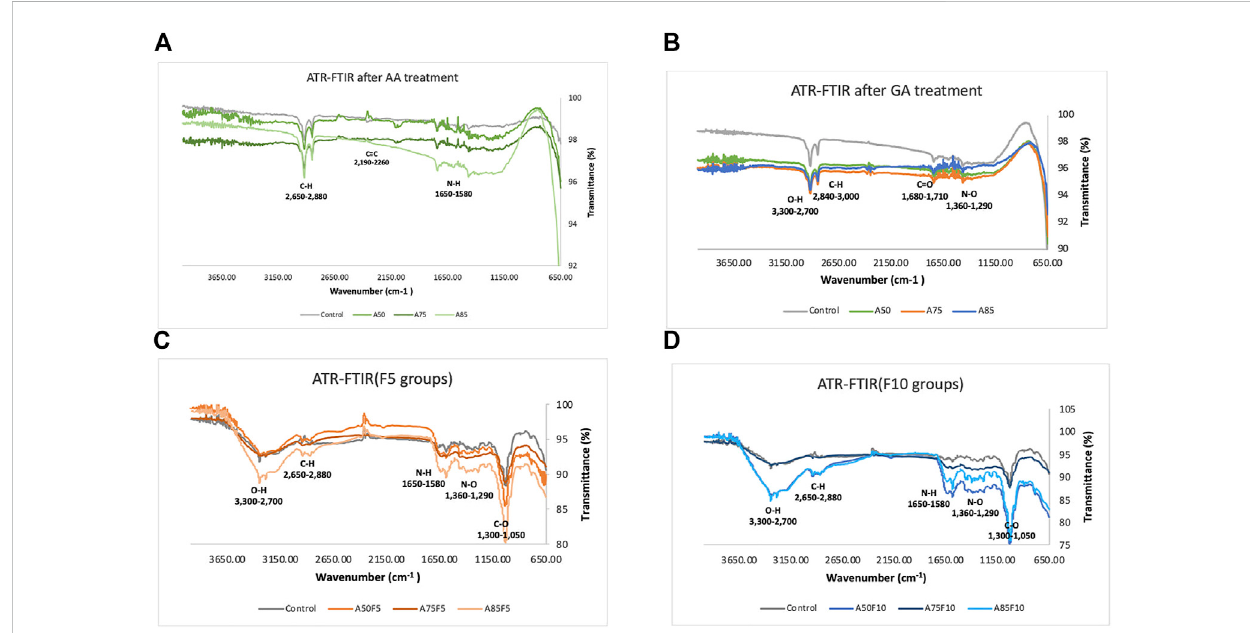
FIGURE 5 Fourier transformed infrared spectroscopy (FTIR) spectra indicating the atomic peaks and functional groups of (A) control and allylamine treated samples, (B) control and allylamine groups after GA treatment, (C) control and fi bronectin 5 µg/mL samples, (D) control and fi bronectin 10 µg/mL samples.